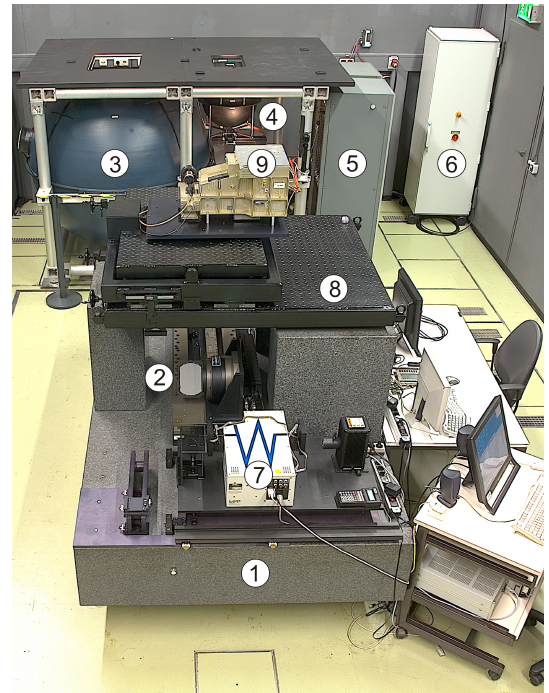
Figure 1: Calibration Home Base (CHB). 1 (cid:13) Calibration bench, 2 (cid:13) Folding mirror, 3 (cid:13) Large integrating sphere, 4 (cid:13) Small integrating sphere, 5 (cid:13) Power supplies of large integrating sphere, 6 (cid:13) Control electron- ics of folding mirror, 7 (cid:13) Monochromator, 8 (cid:13) CHB adapter, 9 (cid:13) Exemplary